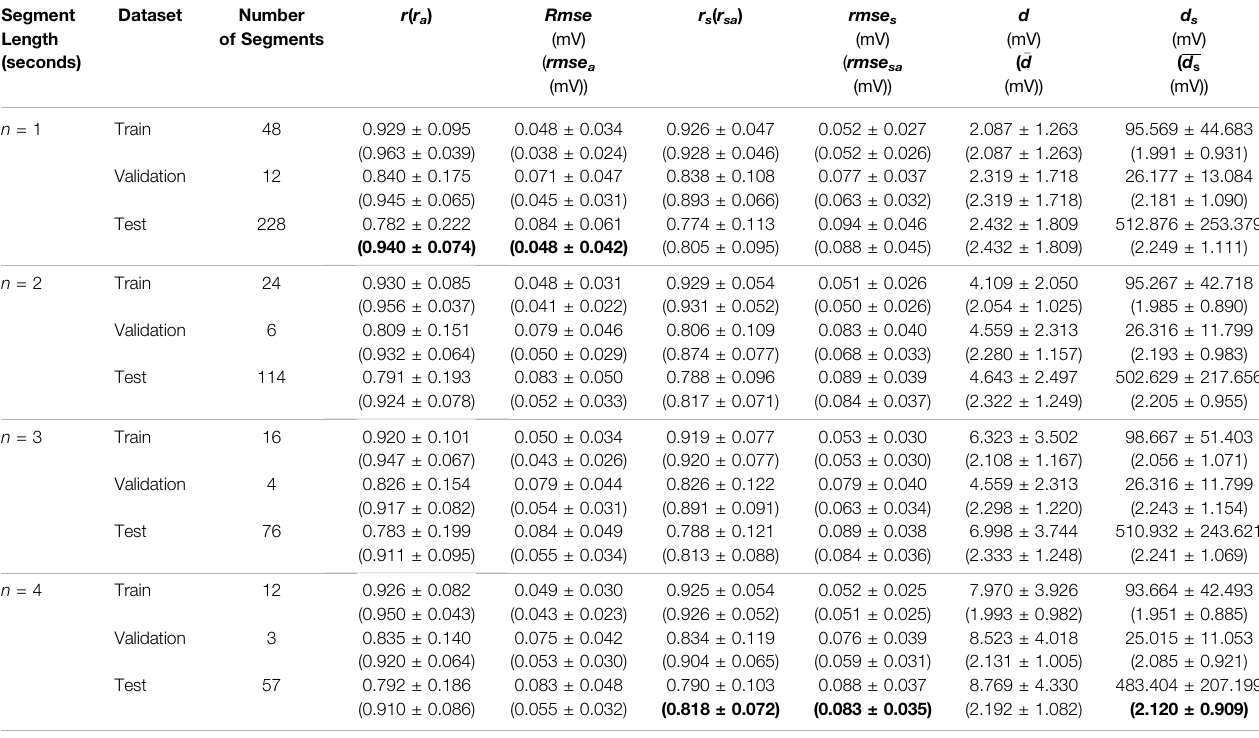
TABLE 1 | The results of the test in different lengths. The abbreviations r , rmse , and d refer to the Pearson ’ s correlation coef fi cient ( r ), root mean square error rmse , and dynamictimewarpingdistancebetweenthereconstructionECGandreferenceECG,respectively.The r s , rmse s and d s representthevaluesbetweenthereconstruction ECG and reference ECG after stitching all the segments together. The abbreviations r a , rmse a , r sa , and rmse sa is calculated after aligning the reconstruction ECG and reference ECG in the cross-correlation. Finally, (cid:1) d and d s represent d and d s divided by the signal time length, respectively.